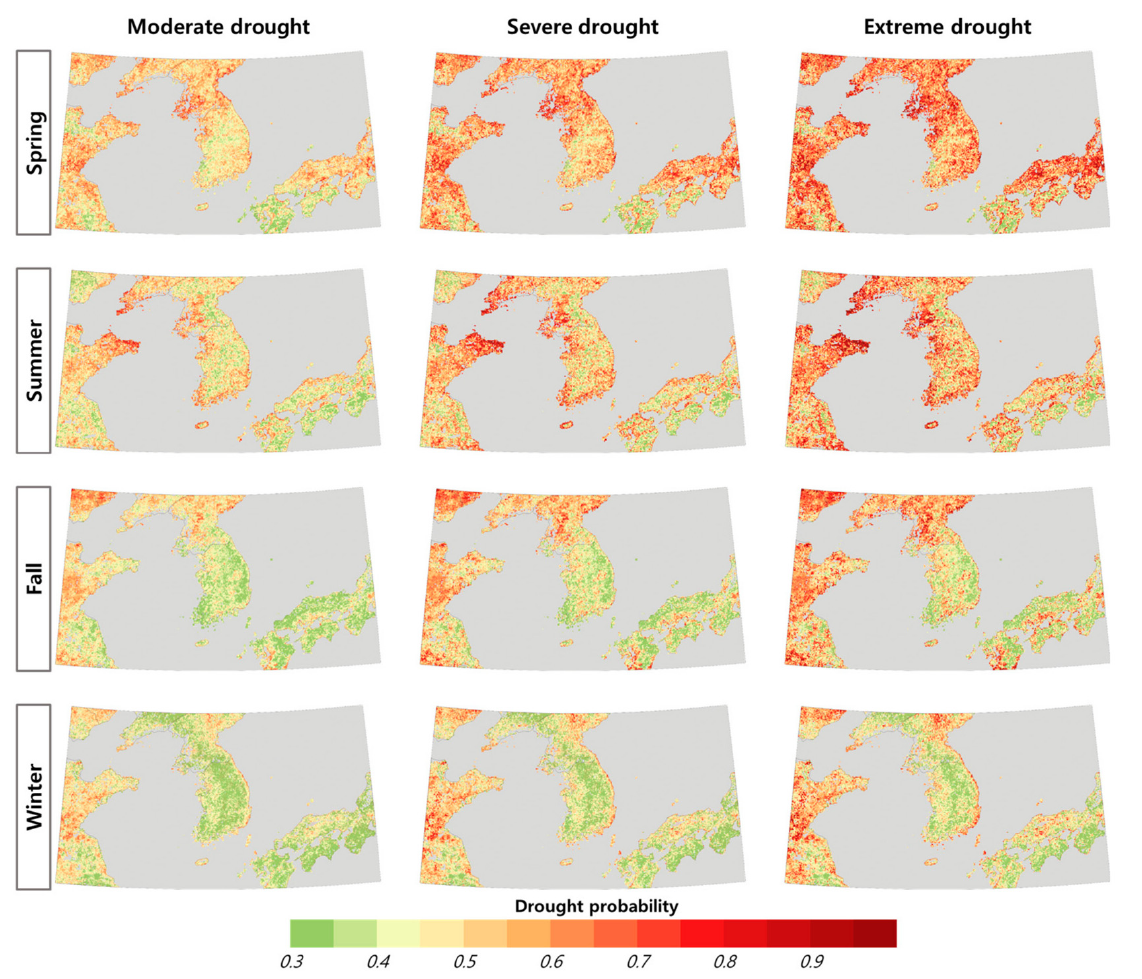
Figure 10. Vegetation drought vulnerability map for VHI threshold ( u VHI ≤ 0.3) under atmospheric excessive water demand